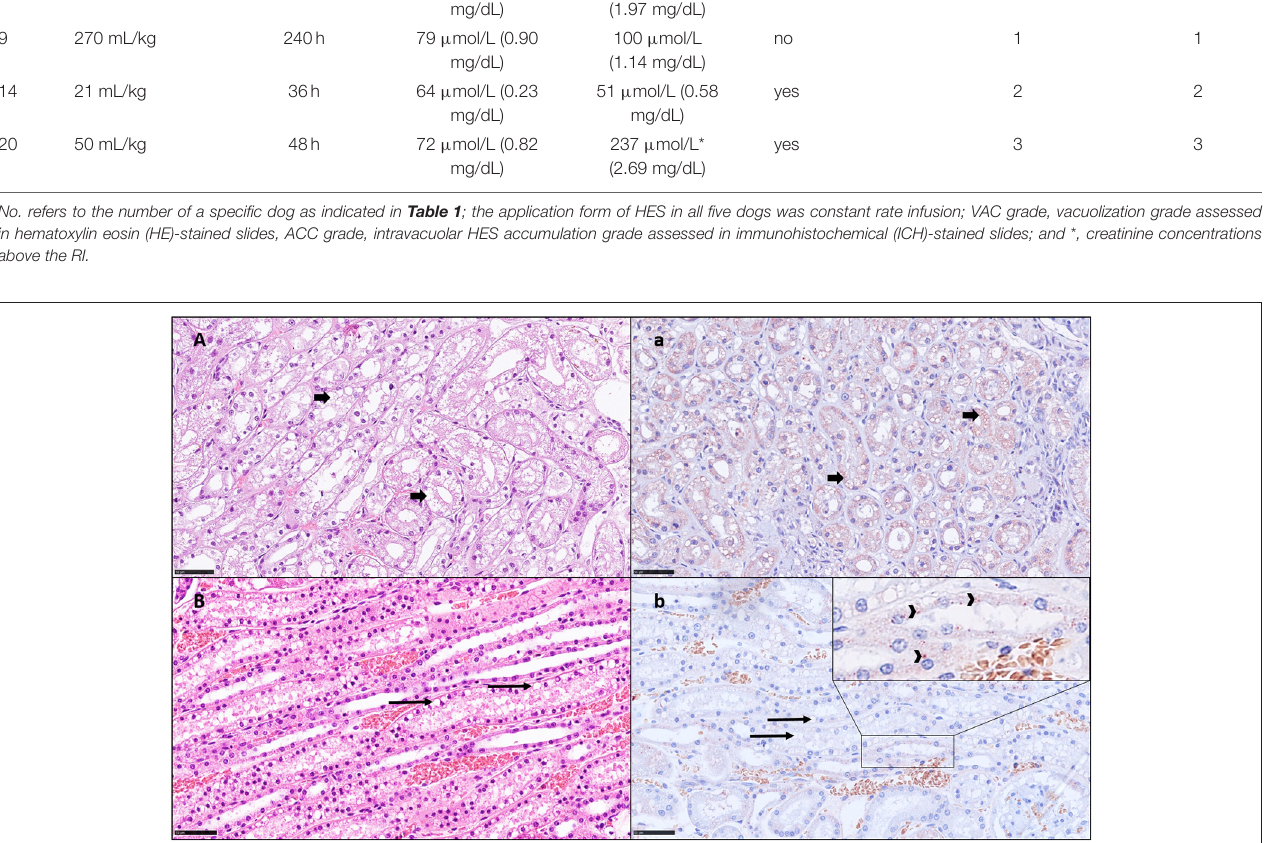
Duration of Creatinine Creatinine time Osmotic application prior to HES of death nephrosis